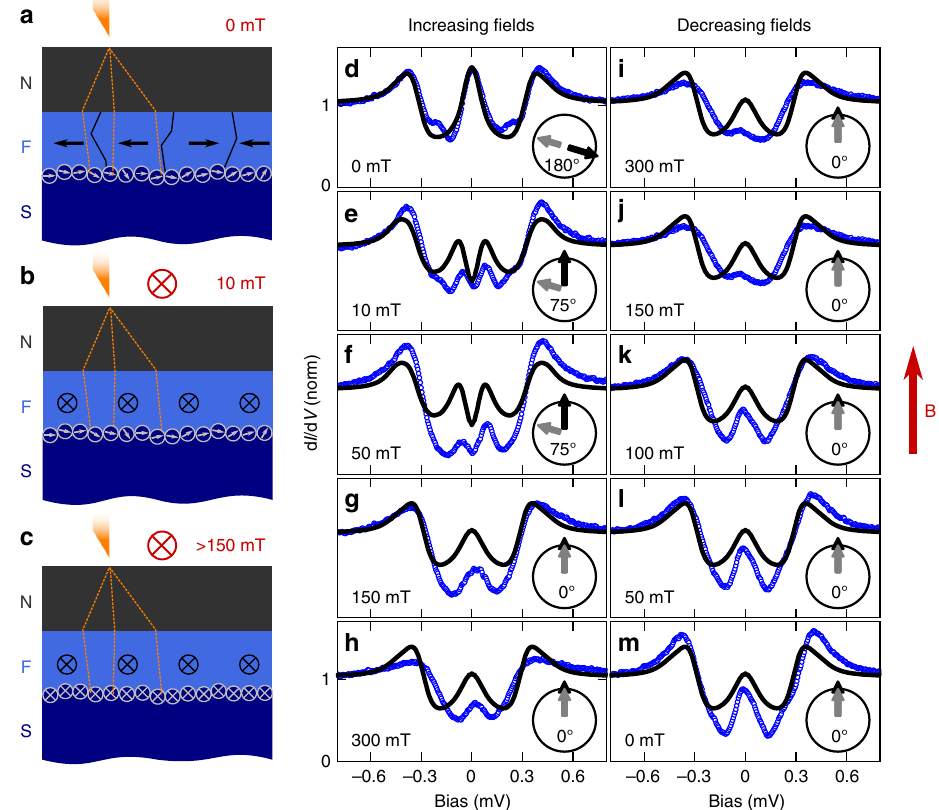
Fig. 4 Model of the magnetisation behaviour of the EuS layer. a The sample in the zero- fi eld cooled (ZFC) state consists of magnetically soft domains (black arrows) with an overall magnetic moment that is random in direction, and harder interface magnetic moments (grey arrows). b The internal domains are expected to follow the external magnetic fi eld (directed into the plane of projection) more readily, aligning at smaller magnetic fi elds. c The interface moments follow the applied fi eld only for higher fi eld values. d – m Experimental d I /d V spectra (blue circles) recorded for the same tunnel contact in varying magnetic fi elds at 290 mK and theoretical spectra (black curves) fi tted to the data. A full up and down sweep is performed to show that the observed curves depend on the magnetisation behaviour of the F layer. The black and grey arrows indicate the fi tted relative angle between the different magnetisations. Direction of the external fi eld is indicated in red. Data were recorded on sample